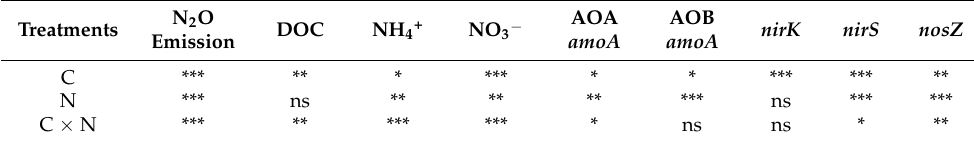
Table 2. Soil DOC, NH 4+ , and NO 3 − contents at different ZnO NPs concentrations (0, 100, 500, and